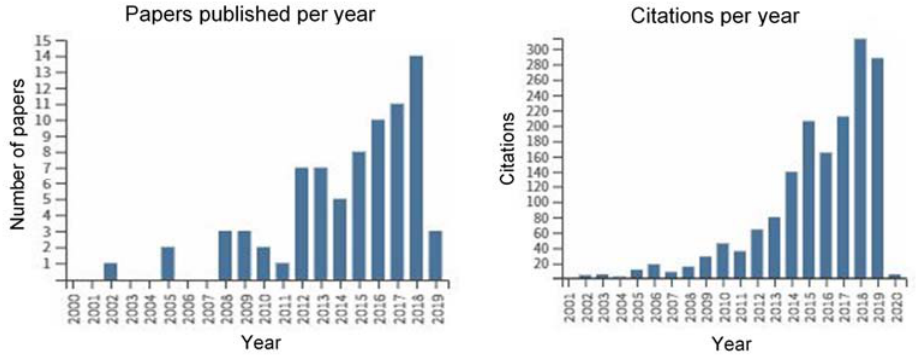
Figure 2. Number of papers published and citations per year found using the keywords “pyrazoles” and “positron emission tomography” and “ 18 F” in Web of Science in the period 2000–2020.